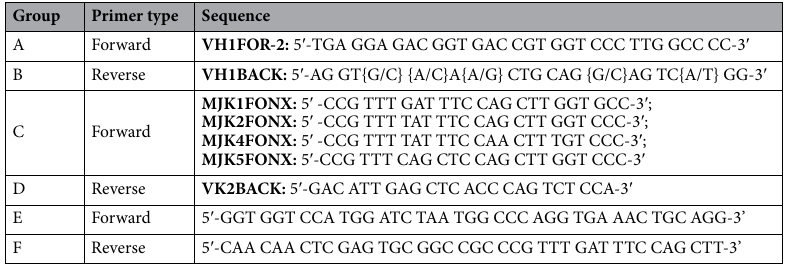
Table 1. Sequence of synthetic oligonucleotide primers used for PCR